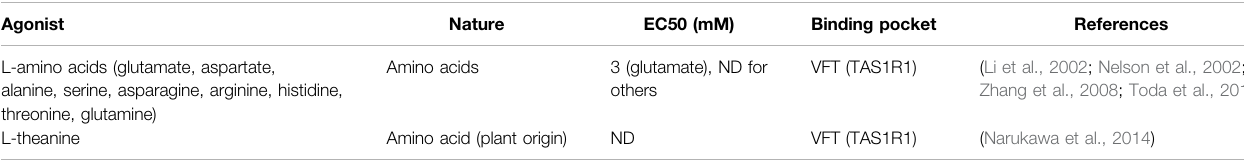
TABLE 5 | Umami receptor agonists with their EC50 values and other pharmacological properties. Agonist